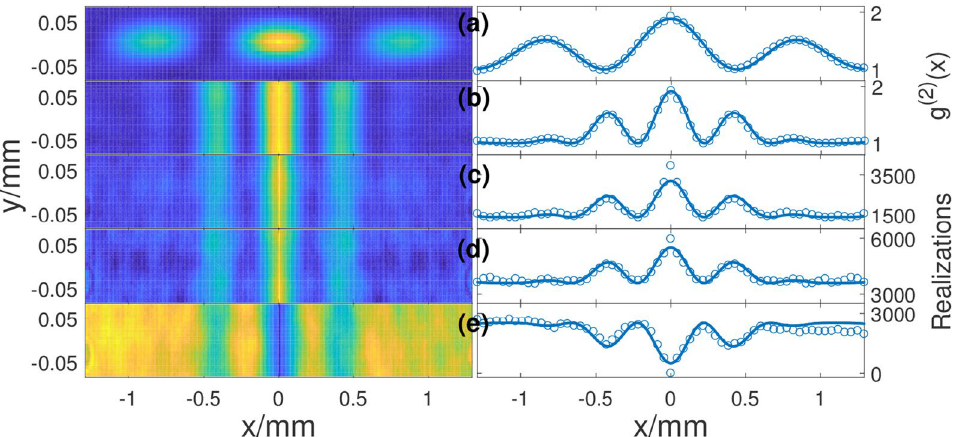
Figure 5. Experimental results. Left column shows the 2-D results and right column shows the corresponding cross section results. In the right column, open circles are experimental results and solid curves are theoretical fitting. ( a ) Normalized second-order correlation between a fixed position (center) and the whole plane. ( b ) 2 ) ( x ) Sub-wavelength correlation. The labels of Y-axis for ( a ) and ( b ) are marked as g ( . ( c ) The realizations when intensities at symmetric positions ( x and − x ) above the average intensity. Similarly, the realizations for the intensities at x and − x below the average intensity are shown in ( d ). ( e ) Negative fringe when the intensity at x greater than the average intensity and the intensity at − x smaller than the average intensity. The labels of Y-axis for ( c )–( e ) are marked as Realizations.